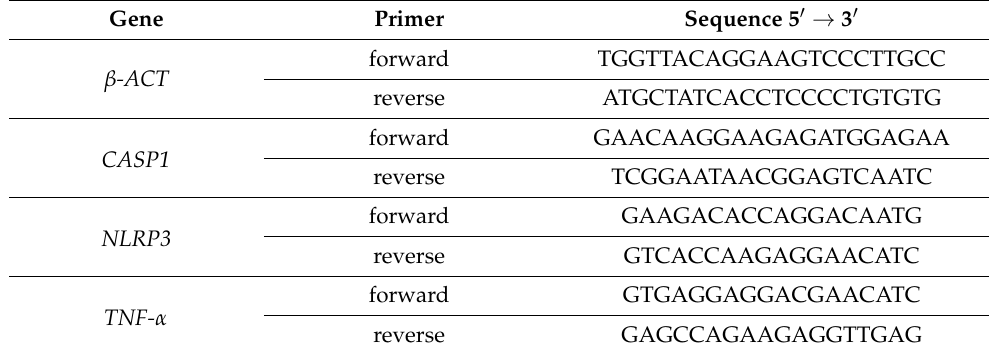
Table 1. Primer sequences used for SYBR green real-time